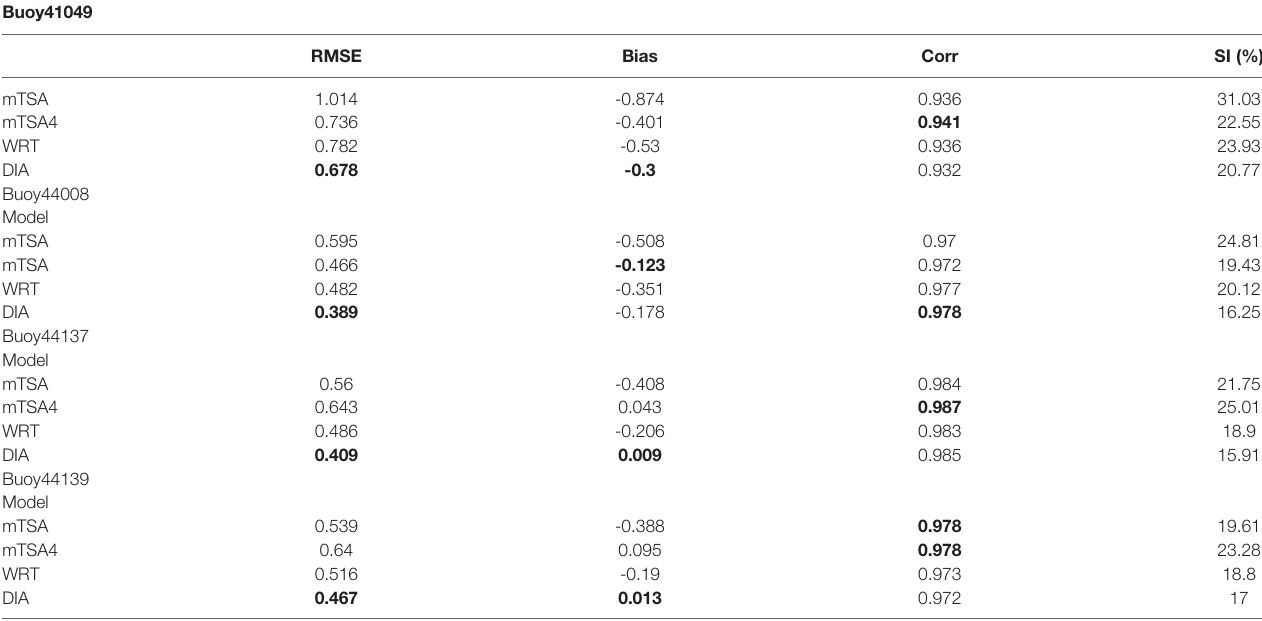
TABLE 2 | Statistics for Hs (m) from WW3 wave model compared to measurements at 4 buoys along or near the storm track of Hurricane Teddy, for root mean square error (RMSE), bias, correlation coef fi cient (corr) and scatter index (SI). Buoy41049 RMSE Bias Corr SI (%)